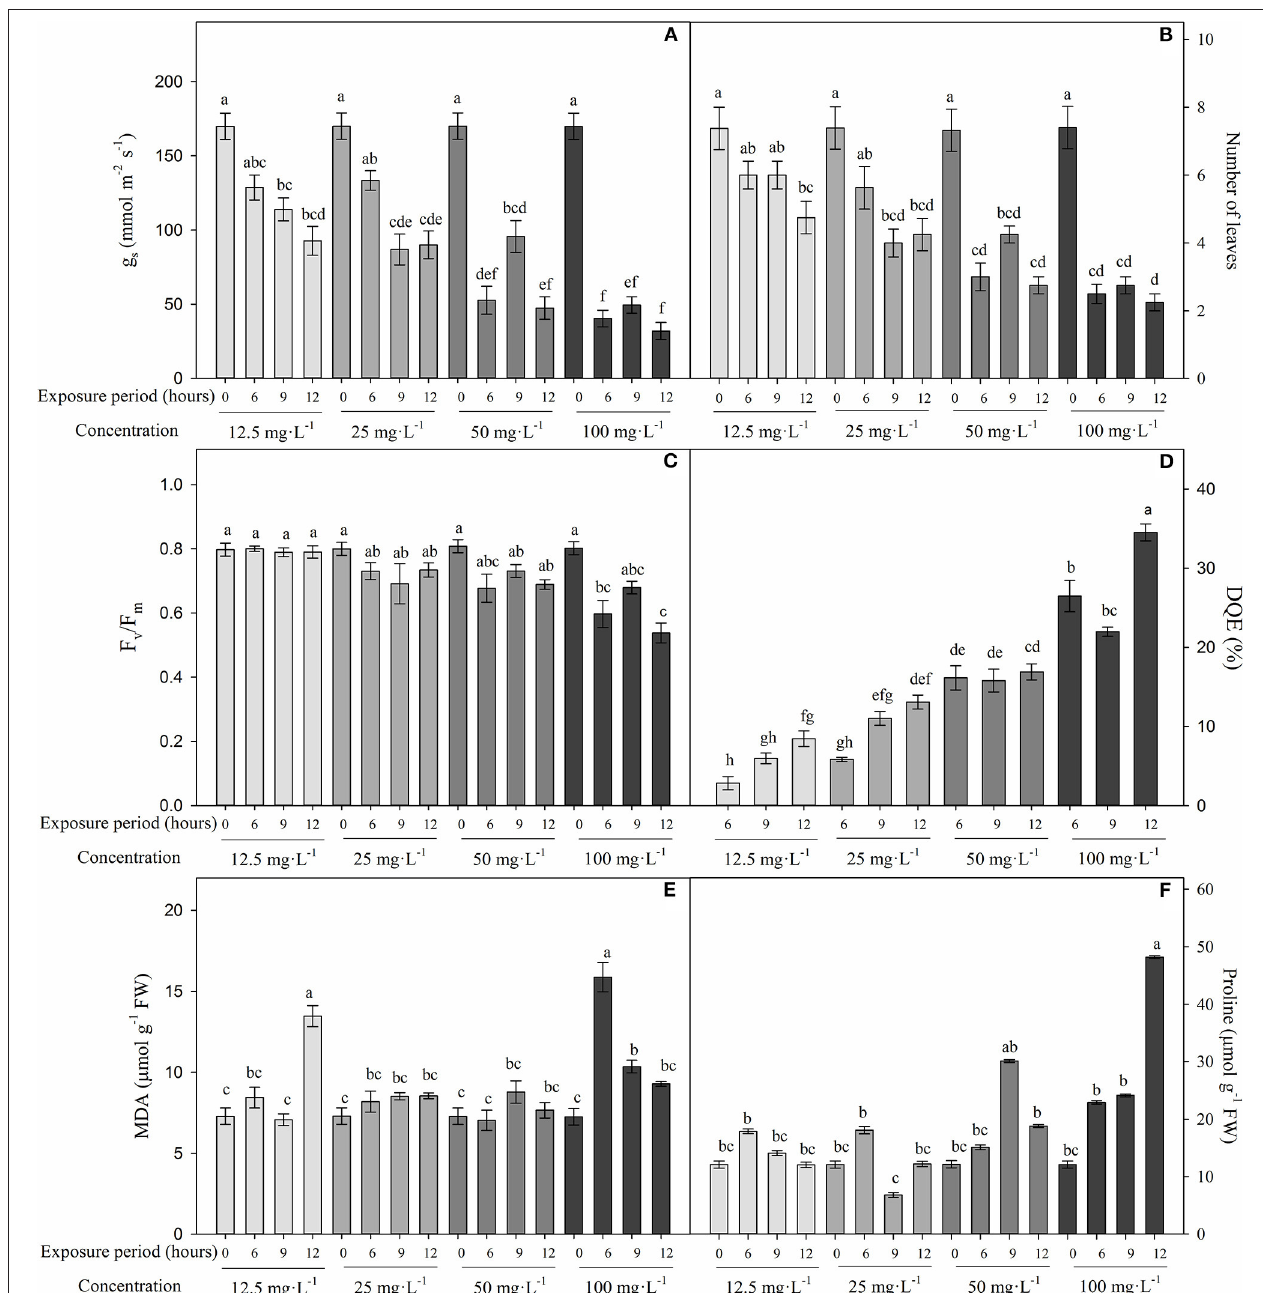
FIGURE 2 | Effect of four concentrations (12.5, 25, 50, and 100mg L − 1 ) of fusaric acid (FA) and three exposure periods (6, 9, and 12h) on the development of cape gooseberry plant ecotype Colombia in a hydroponic system 9 days after treatment. (A) Stomatal conductance ( g s ), (B) number of leaves (C) quantum yield of photosystem II (F v /F m ), (D) maximum efficiency of PSII (DQE), (E) malondialdehyde (MDA) production, and (F) proline content. Bars related to 0h exposure period correspond to control treatment for each evaluated FA concentration. Chart bars represent the mean of three values ± standard error ( n = 3). Bars followed by different letters indicate statistically significant differences according to the Tukey test ( P ≤